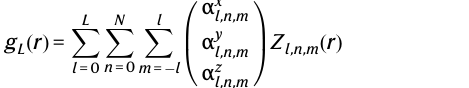
Fig. 8 | Zernike3D work fl ow at particle level. Estimation of the Zernike3D deformation fi eldsfromaparticleimage.Theprocessrequiresthedeformationofa reference map to be consistentwith the dimension of the deformation fi eld, which is de fi ned by the set of Zernike3D coef fi cients. Each coef fi cient component is